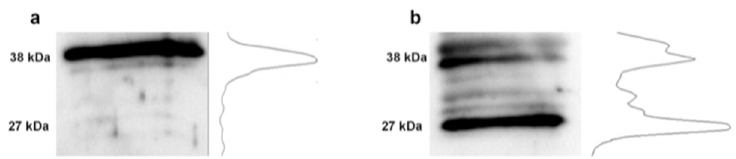
Figure 5 . Glycosylation of Crb3 in control and DiO corneal epithelium. Protein extracts treated with PNGase and then were run on a 12% SDS-PAGE gel. The protein was transferred overnight to a nitrocellulose membrane for Western blotting. The blot was then probed for Crb3. The associated line graphs are indicative of the relative densities within the lane. ( a ) Control; ( b ) DiO .